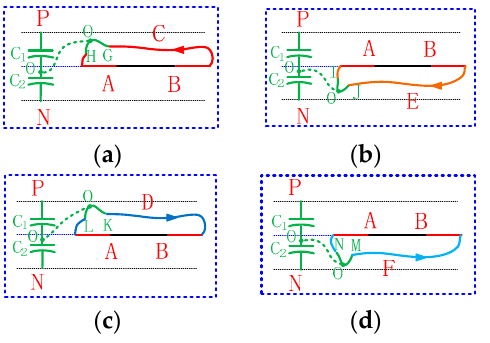
Figure 24. Direct Connection NPC cell under DFUSPWM. ( a ) PFT mode; ( b ) PFB mode; ( c ) NFT mode; ( d ) NFB mode.